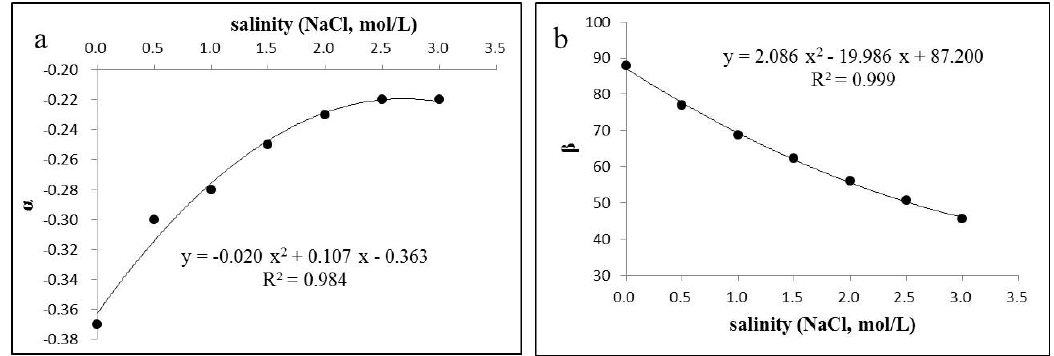
Figure 7. ( a ) Relationship between α and salinity of the NaCl solutions; ( b ) relationship between β and salinity of the NaCl solution.